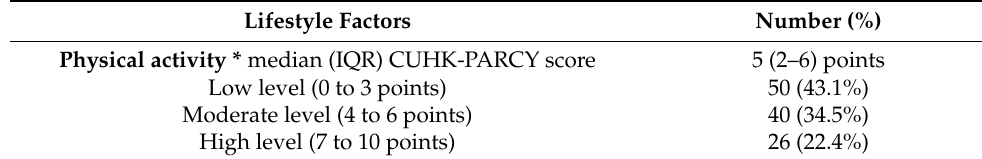
Table 3. Lifestyle factors.